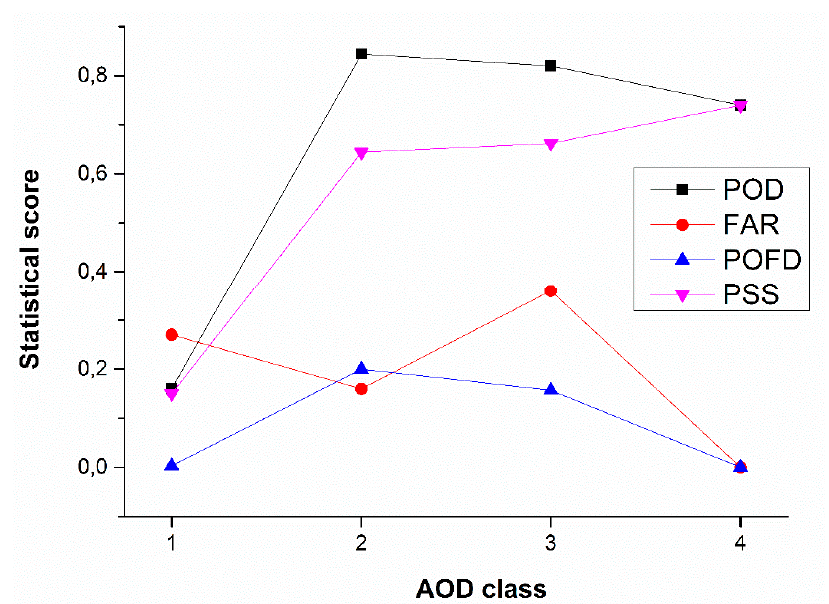
Figure 5. Statistical scores (probability of detection—POD, false alarm ratio—FAR, probability of false detection—POFD, and Peirce skill score—PSS) depicting ANN model accuracy in adequately estimating four different classes of AOD 550 nm values over the Mediterranean basin. Class-1 corresponds to “very low dust”, class-2 to “low dust”, class-3 to “high dust”, and class-4 to “very high dust” conditions.